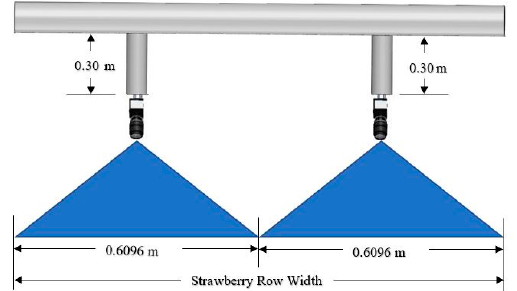
Figure 2. Field of view of two cameras.